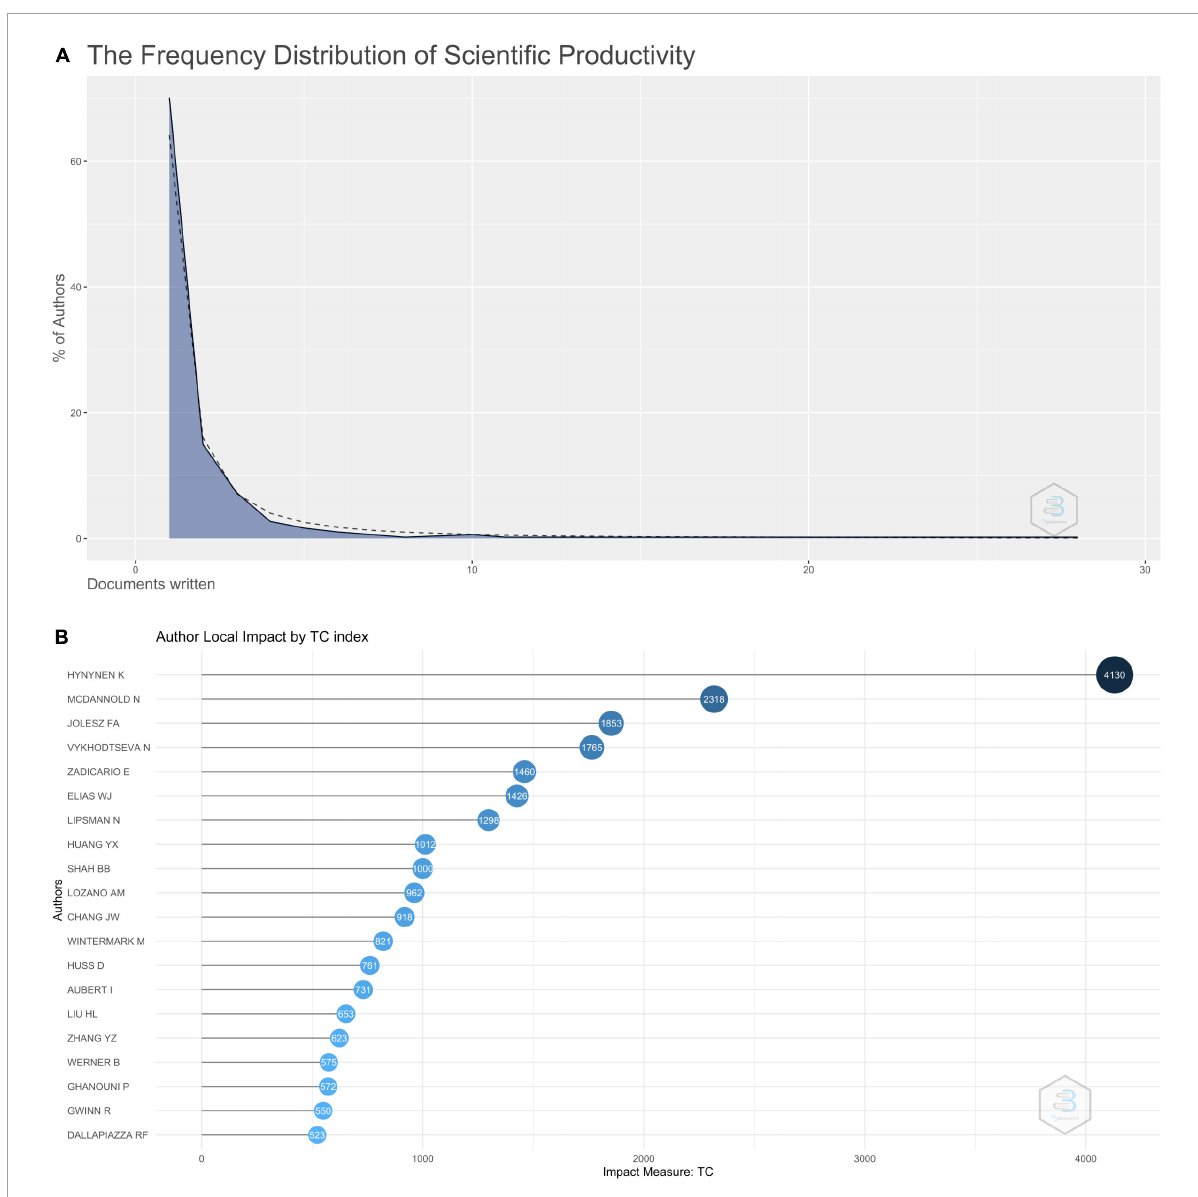
FIGURE3 (A) Graphical representation of Lotka’s law. (B) Graph showing the top 20 authors with maximum impact as measured by total citations received by the top 100 cited articles on